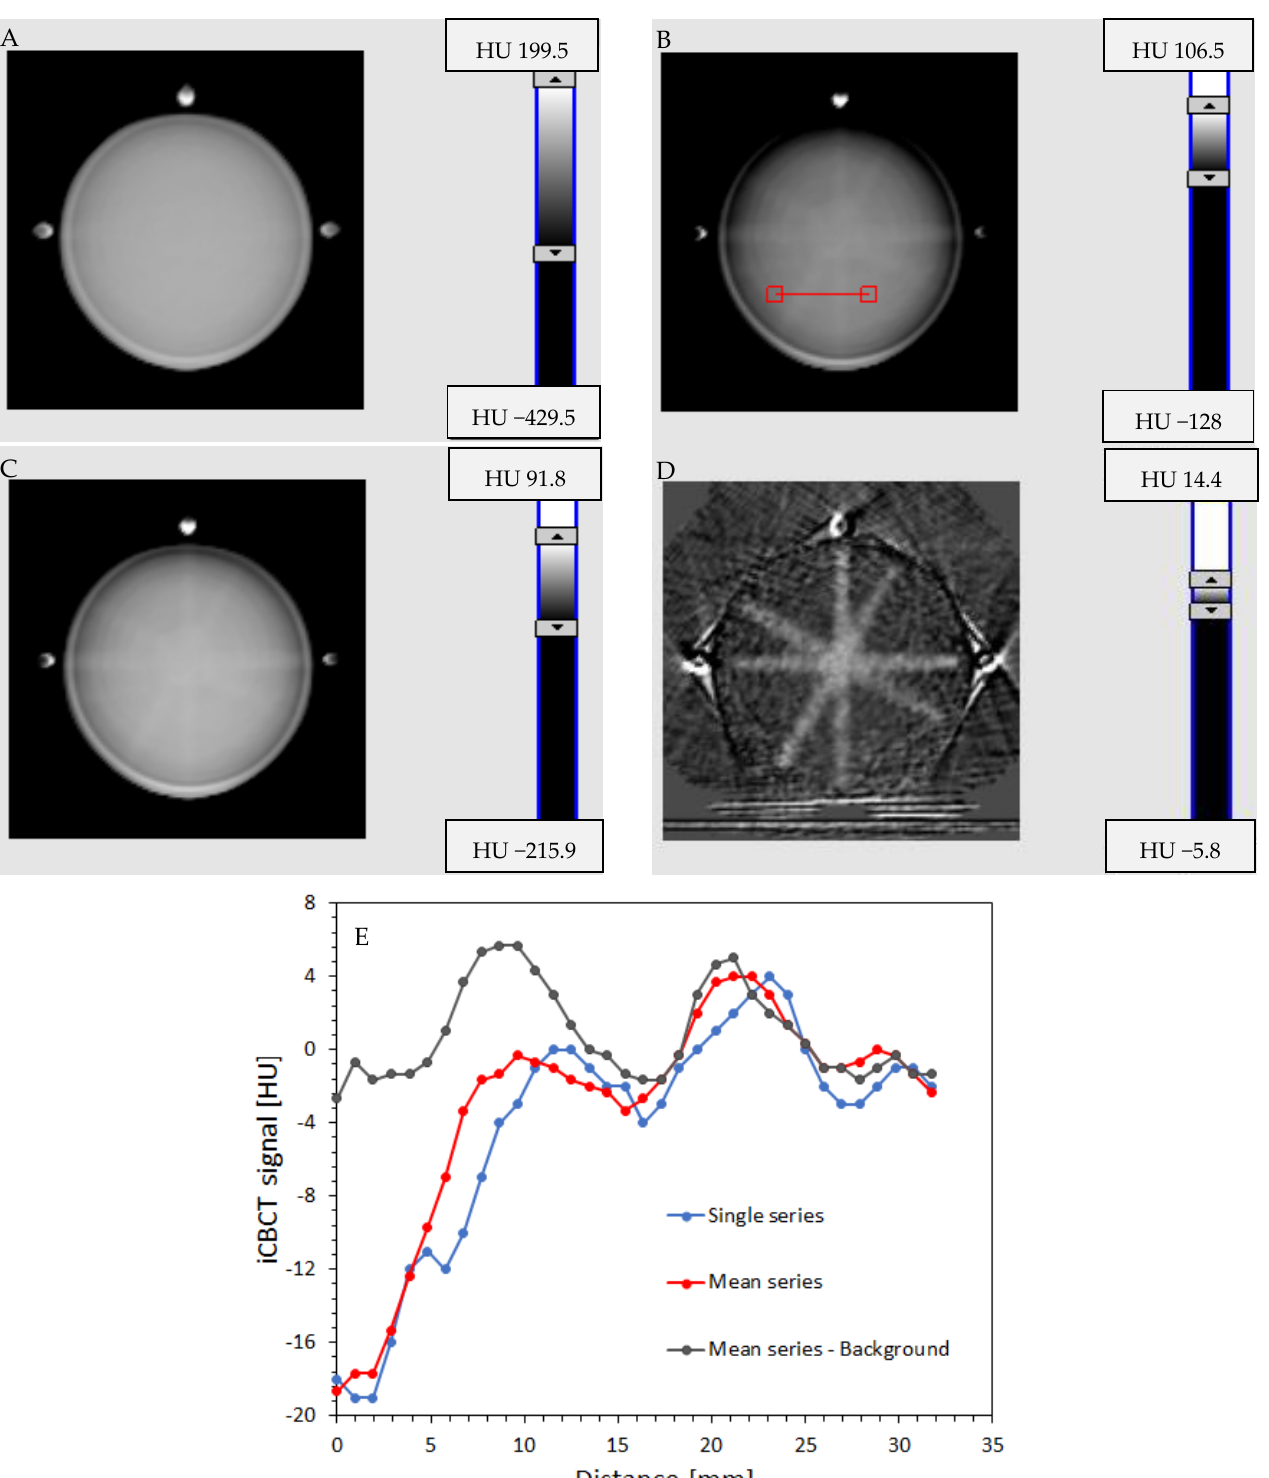
Figure 6. Processing of iCBCT images of PABIG nx in PH-5-DD1 GeVero Co. container irradiated with TrueBeam accelerator (mode: Pelvis): ( A ) is for the background (non-irradiated dosimeter), ( B ) is for one series, ( C ) is for the mean series calculated from three series, ( D ) is the image of ( C ) with the background subtracted ( A – C ), and ( E ) shows the profiles for ( B – D ). The HU scales have been set to best visualize the changes inside the container. The red line in ( B ) shows the position of the profiles.